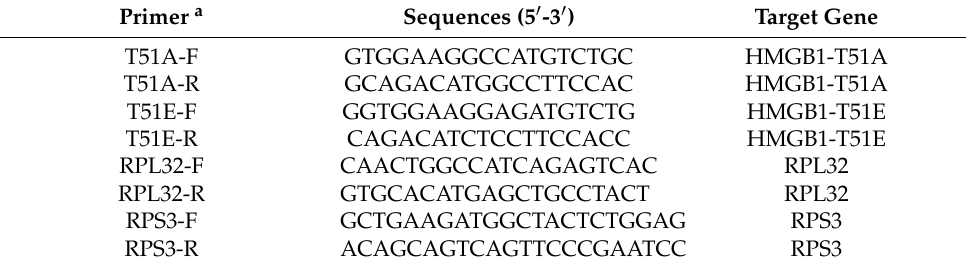
Table 1. List of primers used in this study. Primer